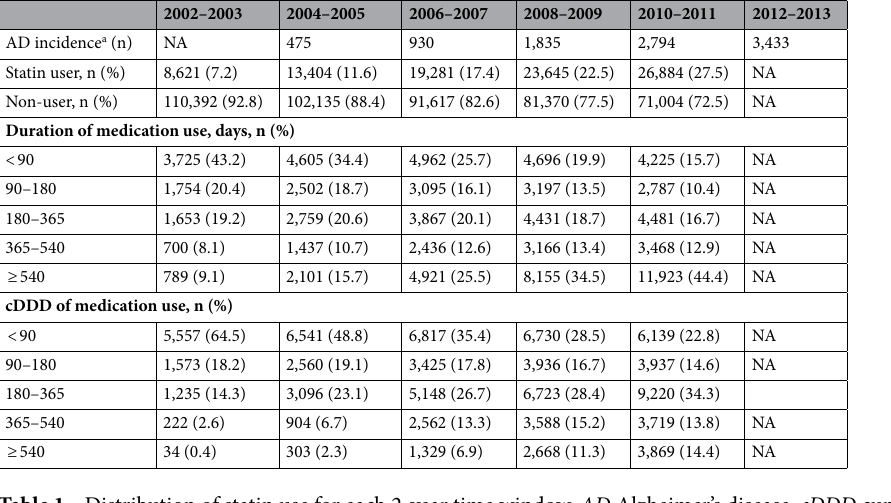
Table 1. Distribution of statin use for each 2-year time window. AD Alzheimer’s disease, cDDD cumulative defined daily dose, NA non-applicable. a Total AD cases =